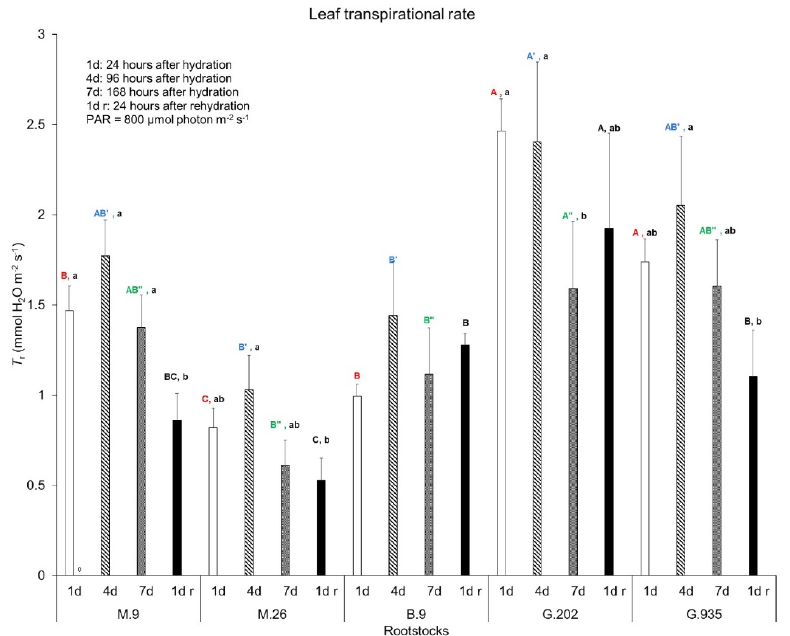
Figure 2. Leaf transpirational rate of Ambrosia TM scion on five rootstocks in the greenhouse water deficit experiment. Bars and error bars are the mean and standard error ( n = 6). Different uppercase letters in the same color indicate significant difference amongst rootstocks on each day (red, blue, and green for Day 1, Day 4 and Day 7 after irrigation, respectively; black for one day after rehydration) ( P ≤ 0.05, ANOVA, Fisher LSD pairwise comparisons). Different lowercase letters in each rootstock indicate significant day-to-day variations ( P ≤ 0.05, ANOVA, Fisher LSD pairwise comparisons).